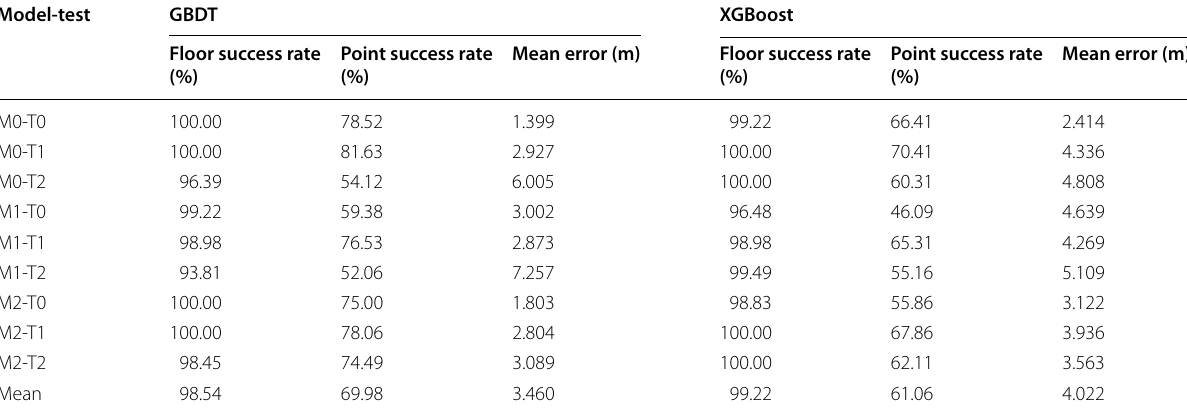
Table 6 The results of different classifiers and testing samples using XGBoost Model-test